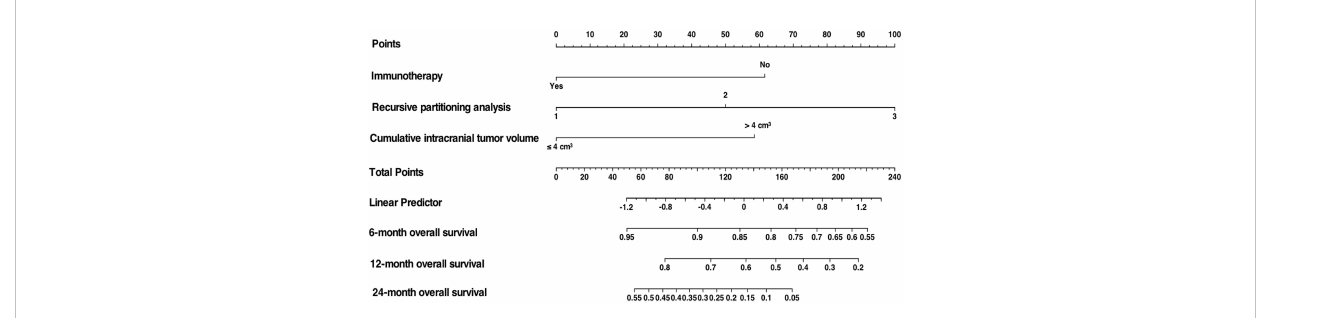
FIGURE 4 Nomogram to predict OS in NSCLCBM patients treated with SRS based on 3 independent prognostic factors identi fi ed in the training